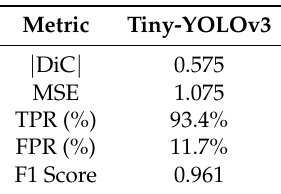
Table 2. Source domain network evaluation metrics.